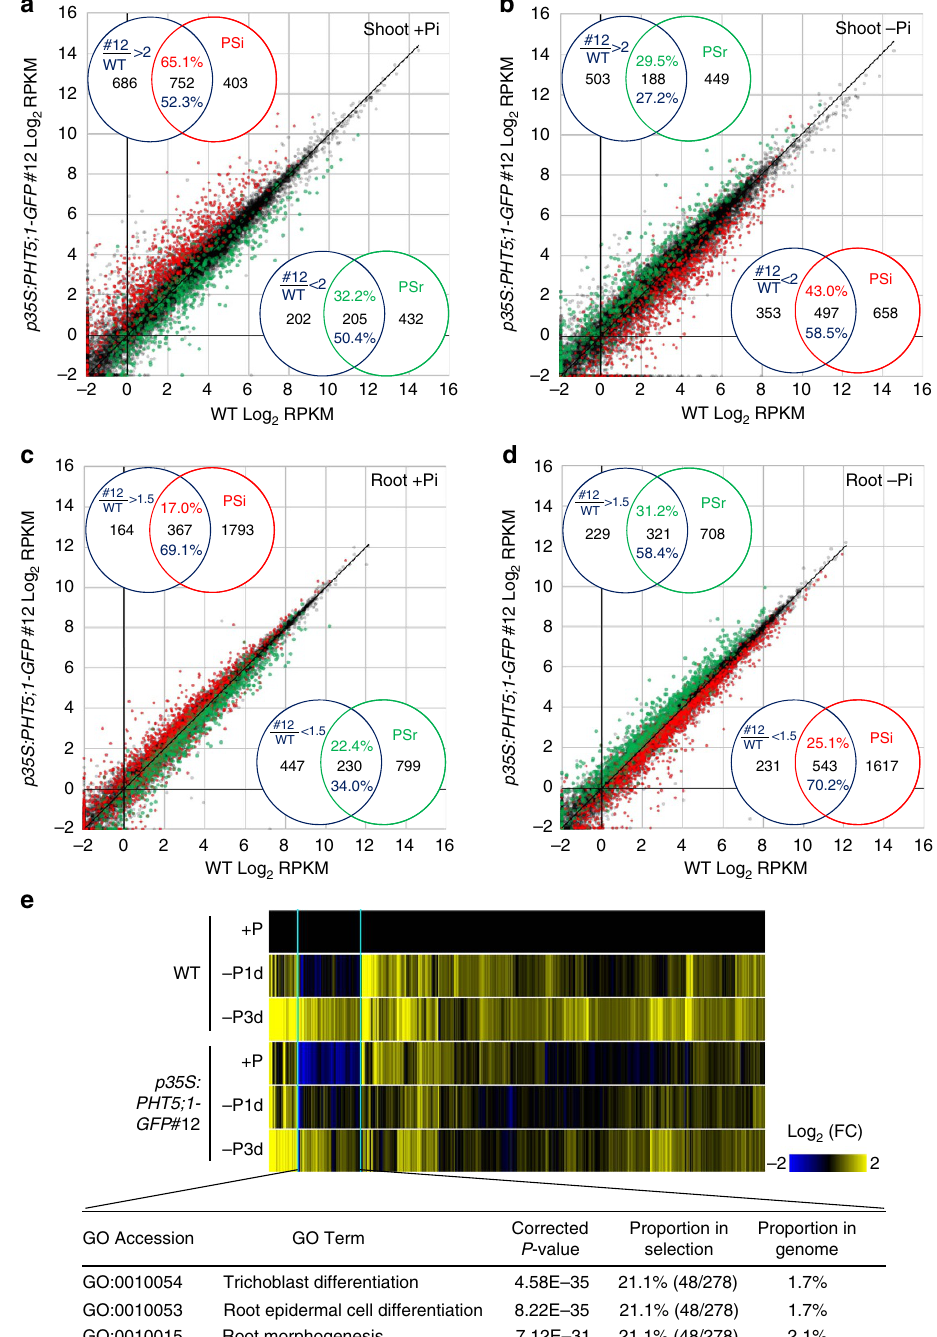
Figure 6 | Overexpression of PHT5;1 leads to misregulation of PSR genes. Scatter plots show the comparison of the gene expression (RPKM) in the shoot ( a , b ) and root ( c , d ) between the PHT5;1-GFP -overexpressing line #12 and WTplants under Pi-sufficient ( þ Pi) ( a , c ) and 3-day Pi-deficient (–Pi) ( b , d ) conditions. Each dot represents an individual gene entity. Red and green dots represent, respectively, the PSi and PSr genes with differential regulation during Pi starvation in the WT ( Z 2-fold change in the shoot and Z 1.5-fold change in the root). Venn diagrams in each panel indicate the overlaps of the genes differentially expressed in the PHT5;1-GFP -overexpressing line compared with WTand PSR genes of WT. It is noteworthy that the WT PSi genes were upregulated in the PHT5;1-GFP -overexpressing line under þ Pi conditions but downregulated under (cid:2) Pi conditions. In a similar manner, the WT PSr genes were downregulated in PHT5;1-GFP -overexpressing line under þ Pi conditions but upregulated under (cid:2) Pi conditions. ( e ) Heat map analyses show the expression of a subset of Pi-starvation-upregulated genes with significant gene ontology (GO) enrichment in the category of root development, which were downregulated in the roots of the PHT5;1-GFP -overexpressing line. P -value was adjusted by Bonferroni correction. NATURE COMMUNICATIONS|7:11095|DOI: